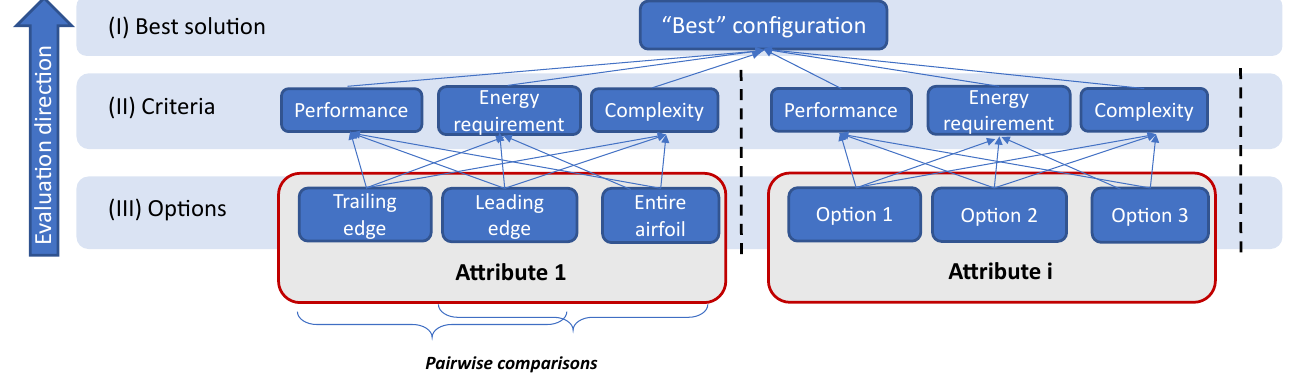
Figure 4. Hierarchical representation of the problem definition by using the